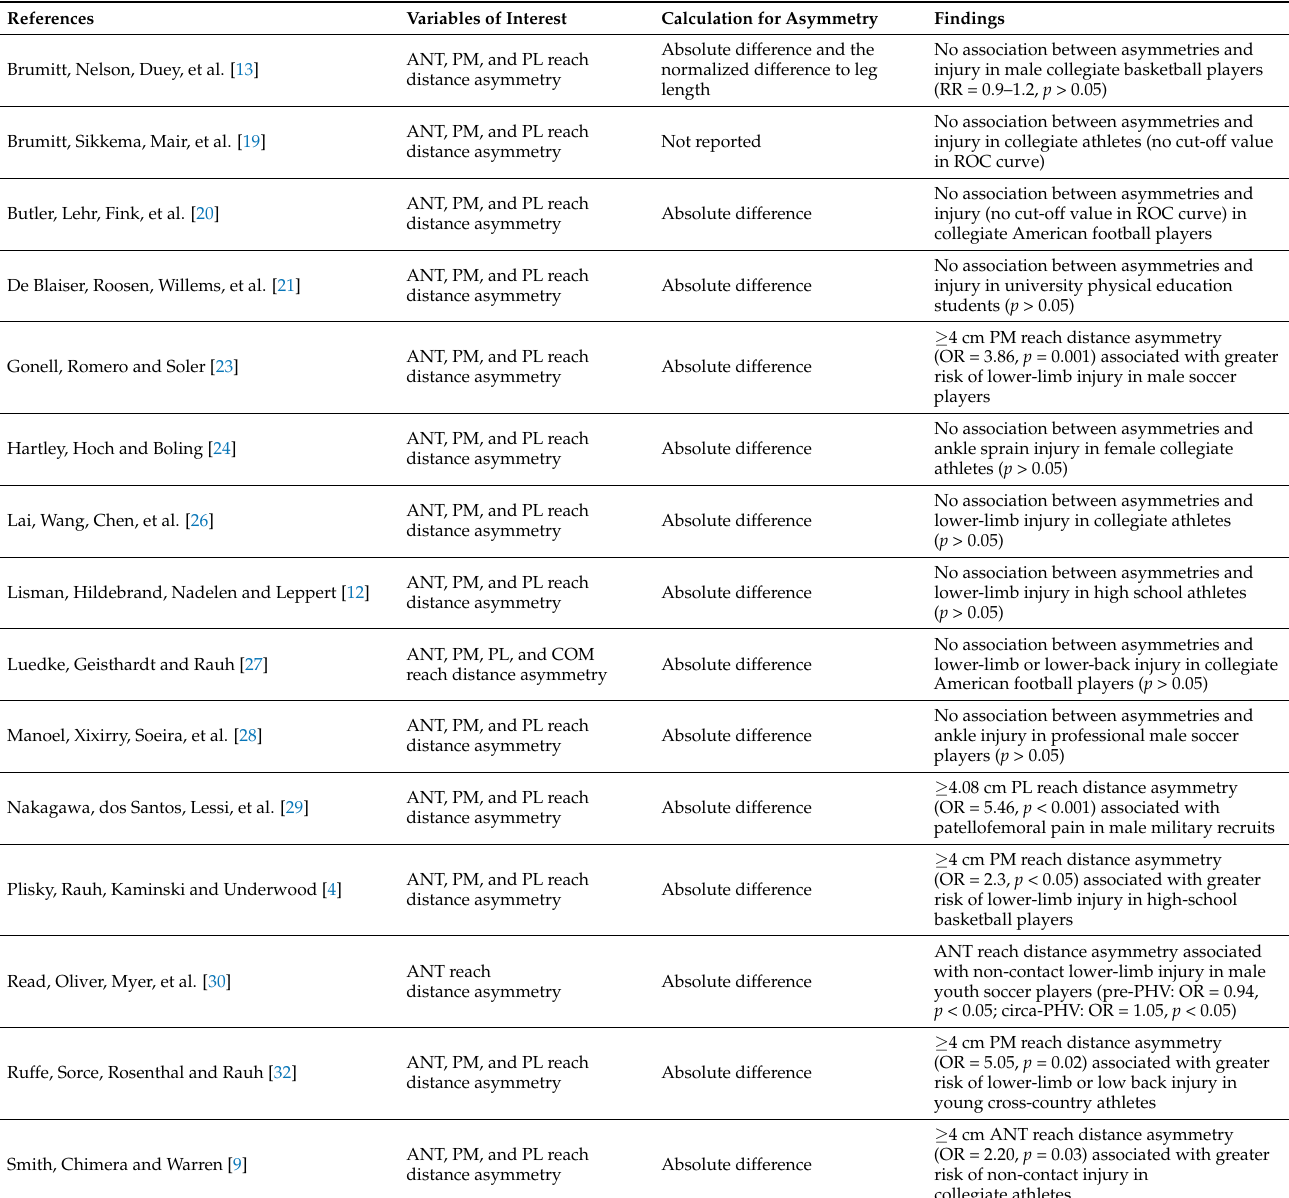
Table 5. Study results—inter-limb asymmetries in dynamic